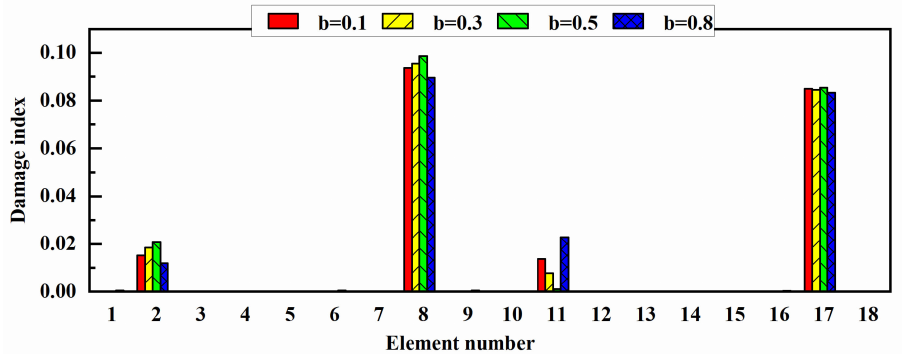
Figure 5. Structural damage detection results under different values of parameter b of the SIPSO algorithm. (Double damages with 10% damage index under 10% noise level).